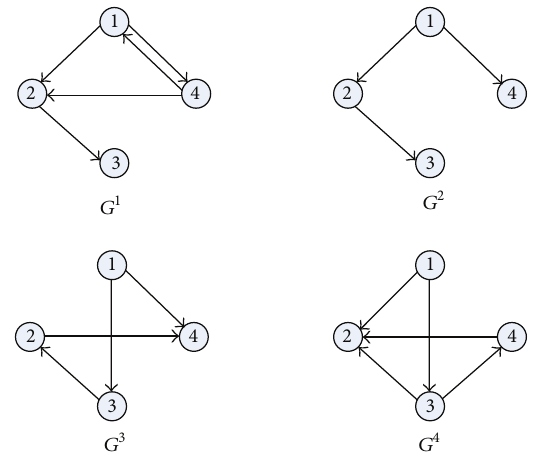
Figure 1: Communication topologies.